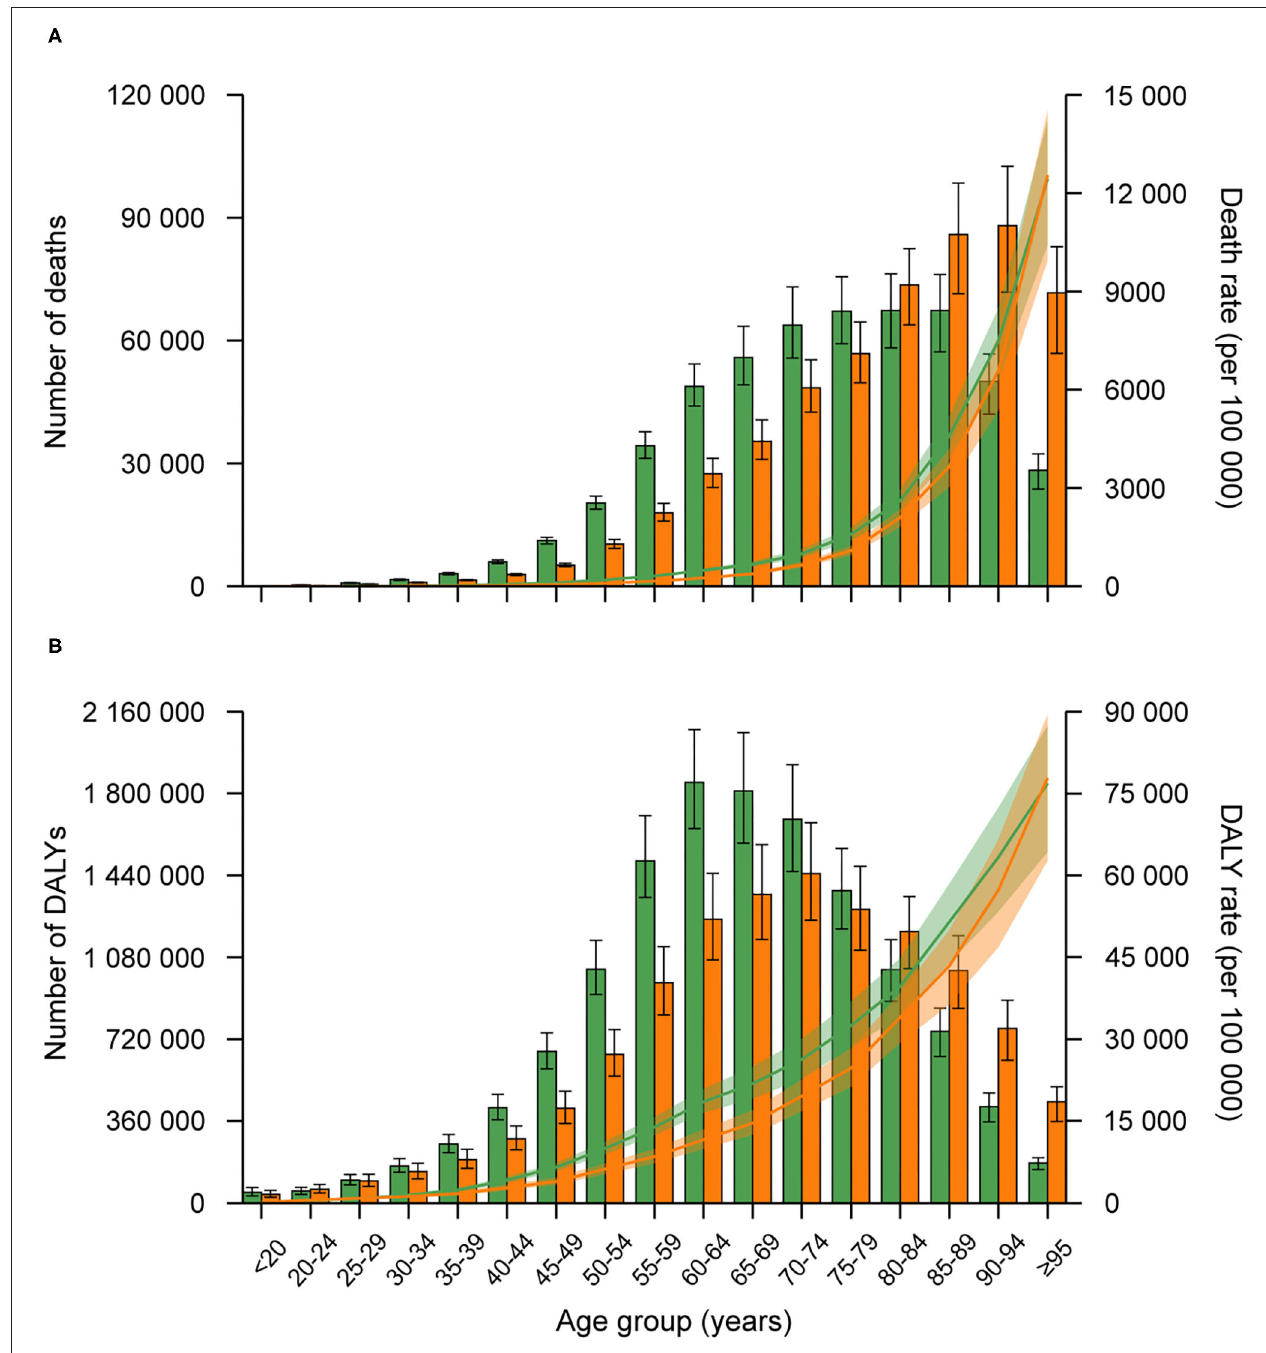
FIGURE 2 | Age-specific numbers and rates of death (A) , and DALYs (B) attributable to metabolic risk factors by sex, 2019. Error bars indicate the 95% uncertainty interval (UI) for numbers. The green bar indicated males, and orange indicated females.